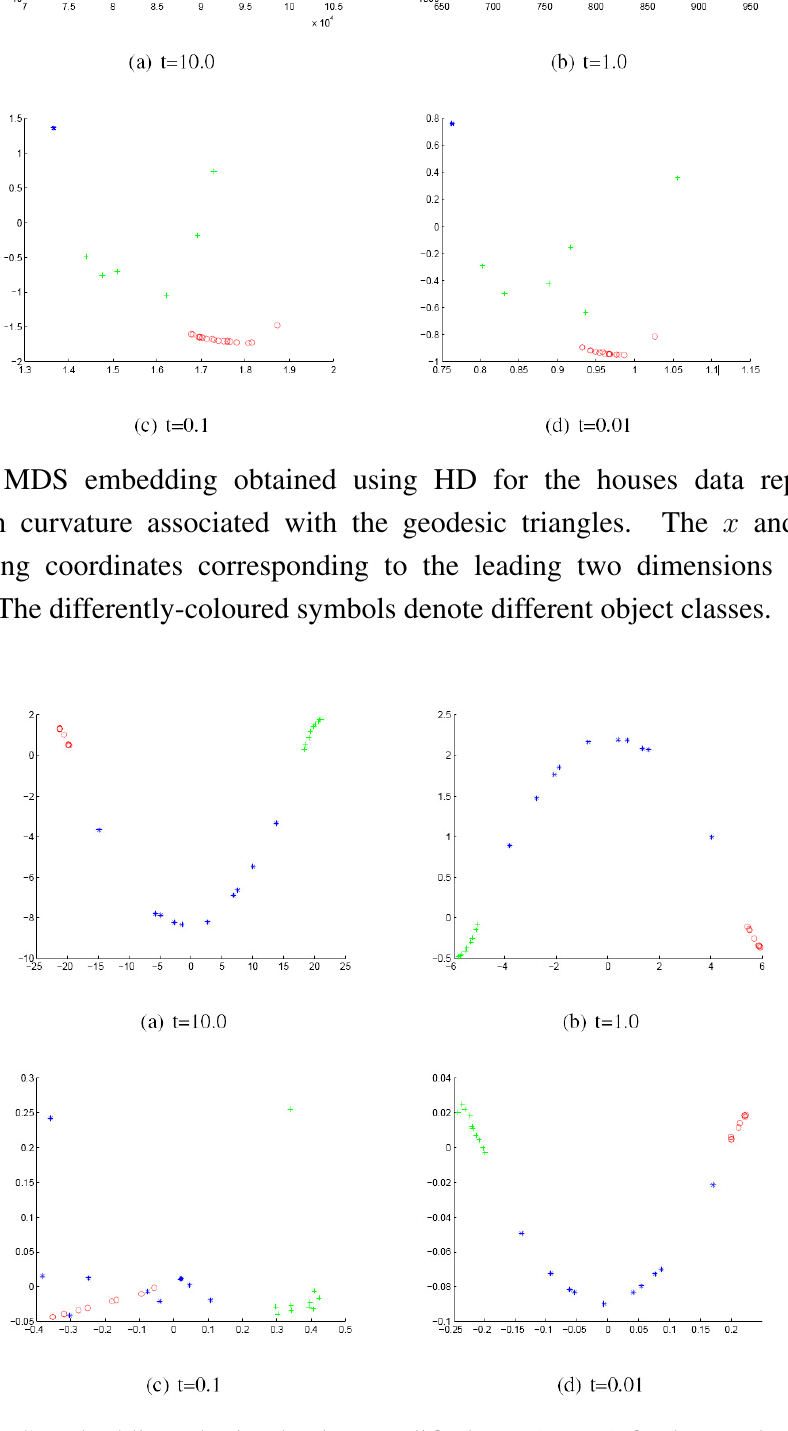
Figure 4. MDS embedding obtained using modified HD (MHD) for house data represented by the sectional curvatures residing on the